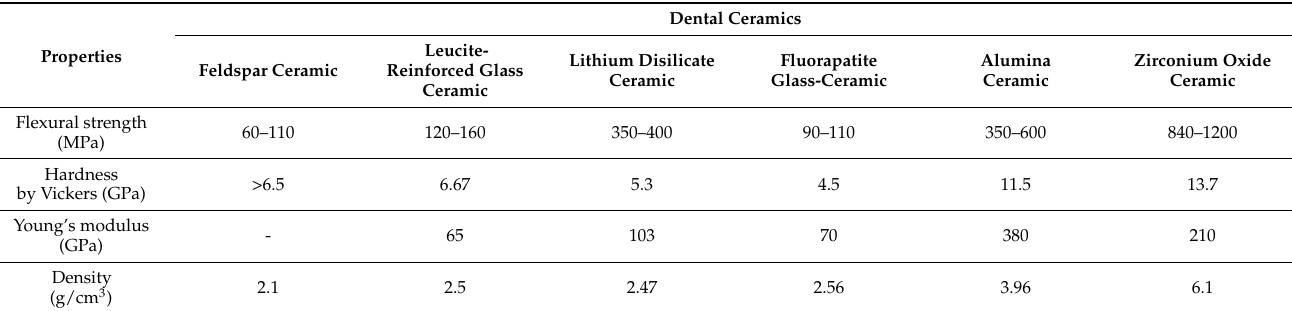
Table 2. Selected properties of various dental